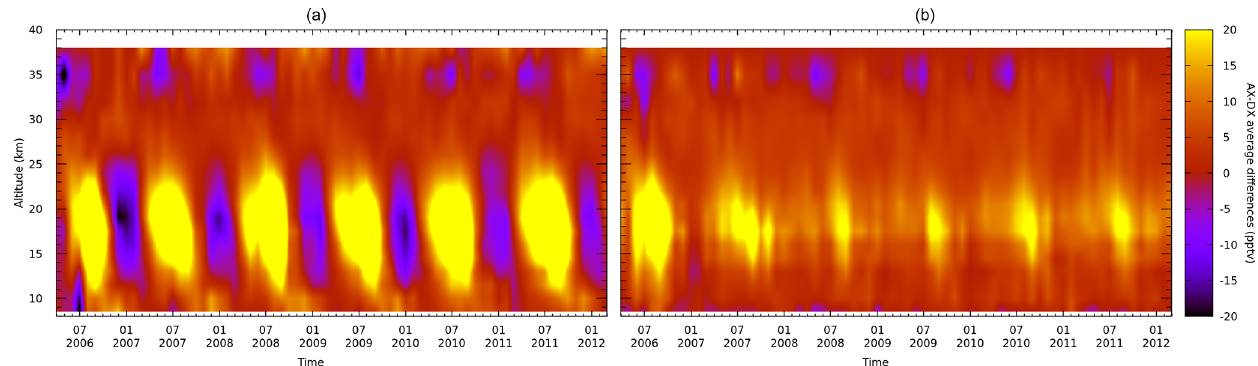
Figure 6. Time series of monthly average CFC-11 ascending–descending difference profiles for V7 (a) and V8 (b) MIPAS/ESA products. The images cover the latitude band from 45 to 60 ◦